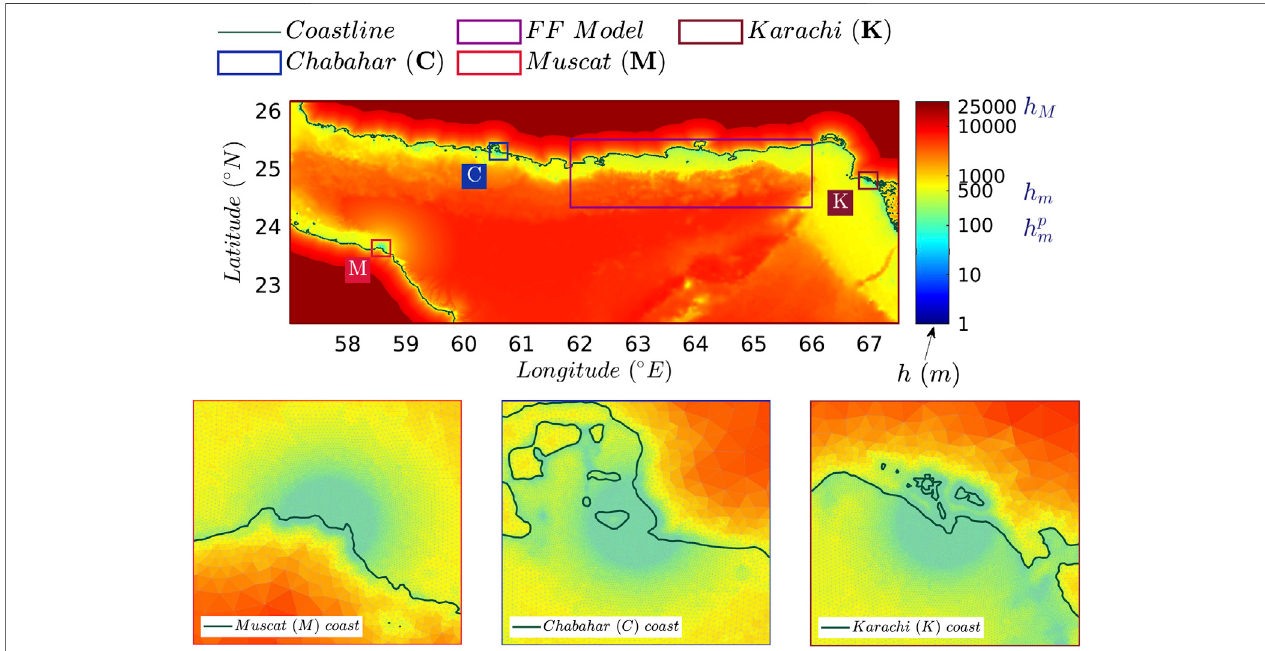
FIGURE3| Localizednon-uniformunstructuredmesh. Top: Meshsizing function (h) supplied toGmshforthe wholedomain. Thelocationofthethreeports under consideration and the extent of the fi nite fault (FF) model for the eastern MSZ are also shown. The color scale marks the maximum mesh size h M (cid:2) 25 km on land, the meshsizeatthecoast h m (cid:2) 500m,andthere fi nedmeshsizeh p m =100mfortheports. Bottom: Zoominofthelocallyre fi nedmeshes(ofsizeh p m )atascaleof32km × 32 km for the three ports, Muscat (left) , Chabahar (middle) and Karachi (right) .